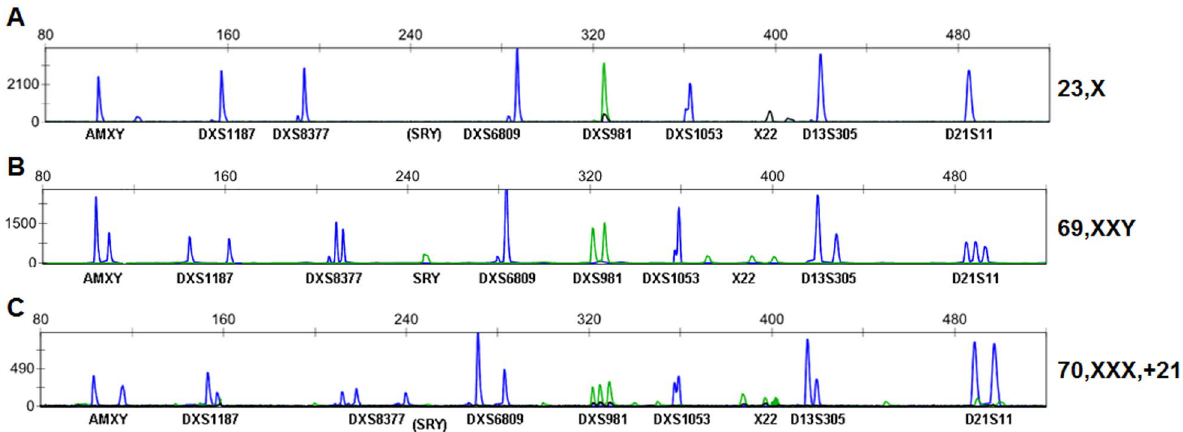
Figure 4. Capillary electrophoresis results for three samples with sex chromosomal aneuploidies identified in the prospective examination, including (A) a suspected 23, X finally confirmed by karyotyping, (B) a case of triploidy ‘69, XXX’, and (C) a case of triploidy with an additional chromosome 21 (70, XXX, + 21).